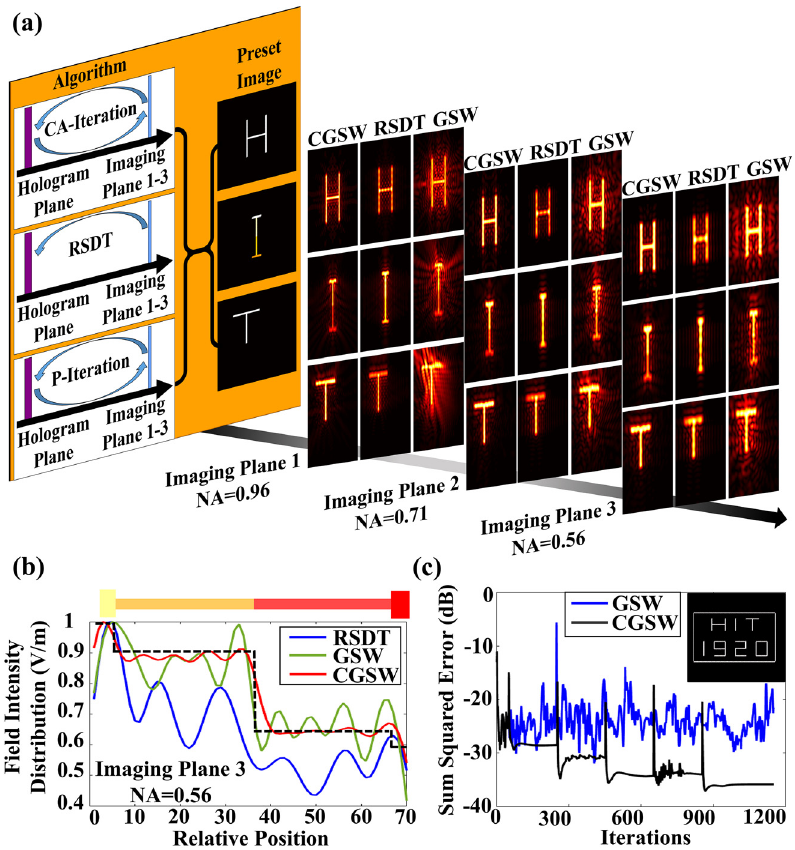
Figure 2: Comparison of image reconstruction capabilities of complex-weighted Gerchberg – Saxton (CGSW), Rayleigh – Sommerfeld diffraction theory (RSDT) and weighted Gerchberg – Saxton